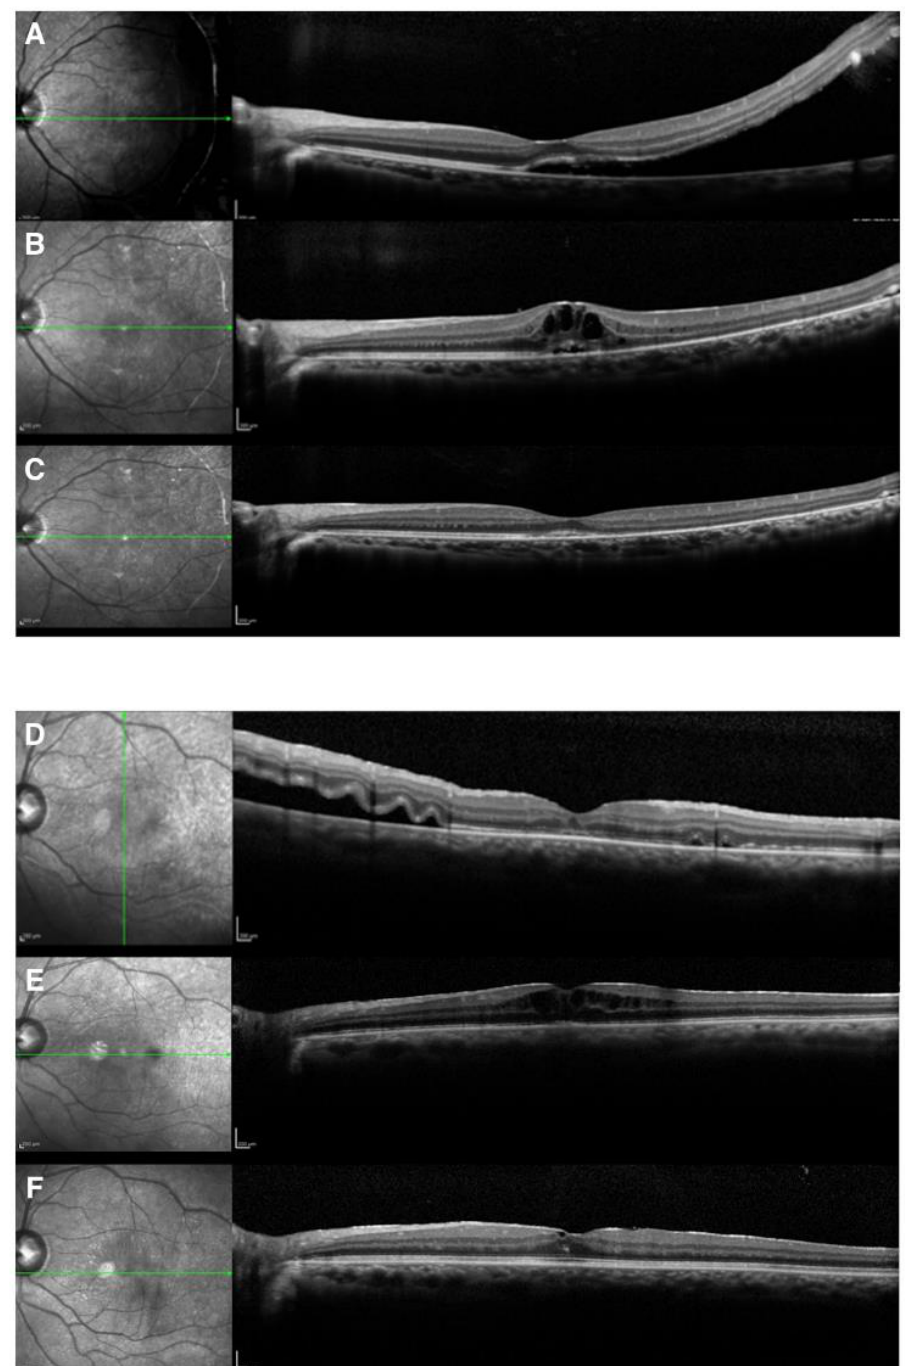
Figure 2. Cases 1 and 2 are presented as representative cases. Case 1: preoperative OCT ( A ); post- operative CME ( B ); OCT at 1 year after surgery ( C ). Case 2: preoperative OCT ( D ); postoperative CME ( E ); OCT at 1 year after surgery ( F ). Both ( A ) and ( D ) showed macular detachment before surgery. As for the timing of onset of postoperative CME, ( B ) showed CME 1 month after surgery, and ( E ) showed CME 2 weeks later. CME disappeared in ( C ) but was found to have remained 1 year after surgery ( F